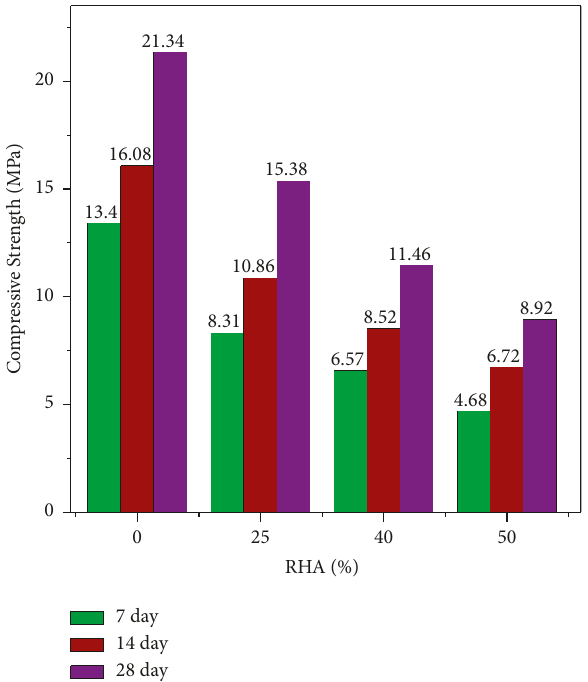
Figure 20: Compressive strength of concrete without SP [56].